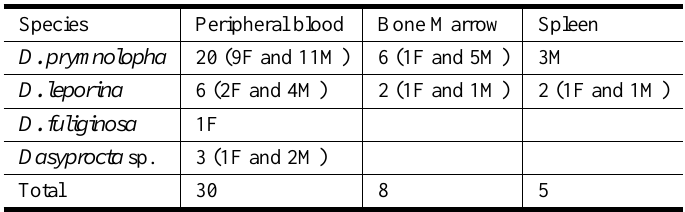
Species and number of animals specified by sex, using preparations ob- tained with different tissues. Species Peripheral blood Bone Marrow